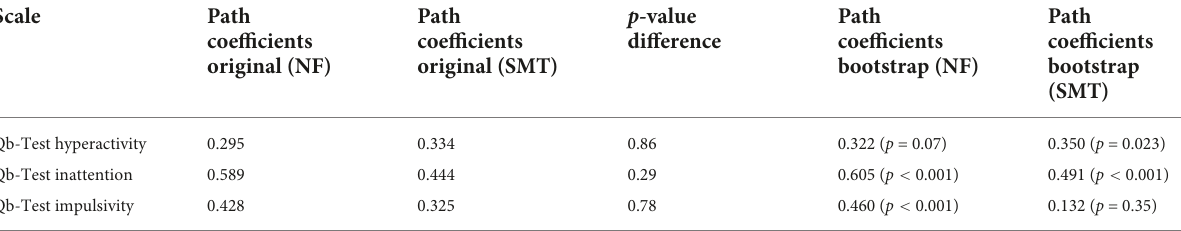
TABLE 4 Original path coefficients of Qb-Test subscales in NF ( n = 55) and SMT ( n = 58) after imputing missing values with k-nearest neighbor (kNN) algorithm.